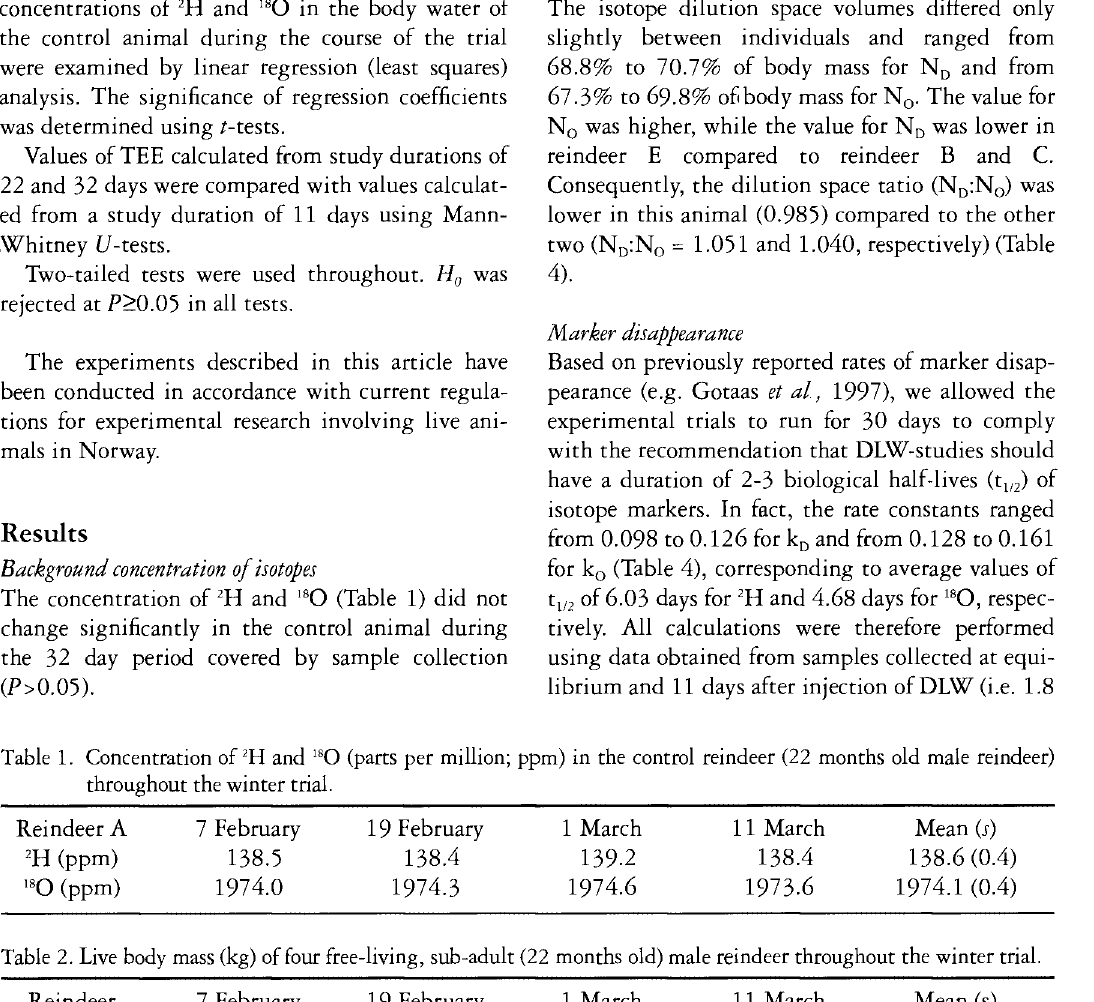
Table 2. Live body mass (kg) of four free-living, sub-adult (22 months old) male reindeer throughout the winter trial.